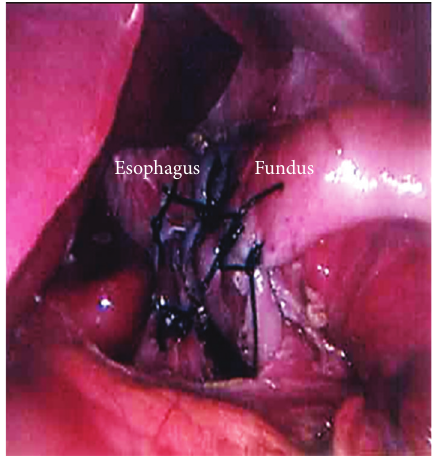
Figure 3: Laparoscopic Nissen fundoplication technique. Com- pleted 360 ∘